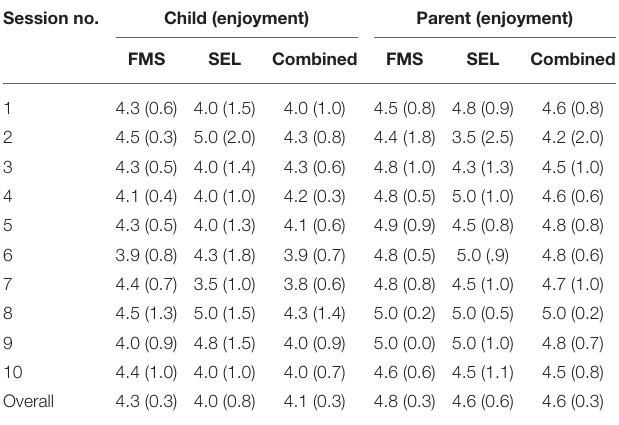
TABLE 6 | Changes in FMS, social skills, emotion expressiveness, regulation, and knowledge. Pre Post t p Effect M (SD) M (SD) size a Emotion knowledge 28.40 (4.77) 31.00 (2.26) − 1.85 0.098 0.58 Social skills 94.00 (8.94) 102.36 (3.05) − 4.57 0.001 1.38 Emotion expressiveness 13.09 (2.95) 14.82 (2.56) − 2.61 0.026 0.79 Emotion regulation 11.36 (2.16) 12.55 (2.38) − 1.46 0.174 0.44 FMS 239.1 (34.02) 246.73 (24.24) − 1.40 0.191